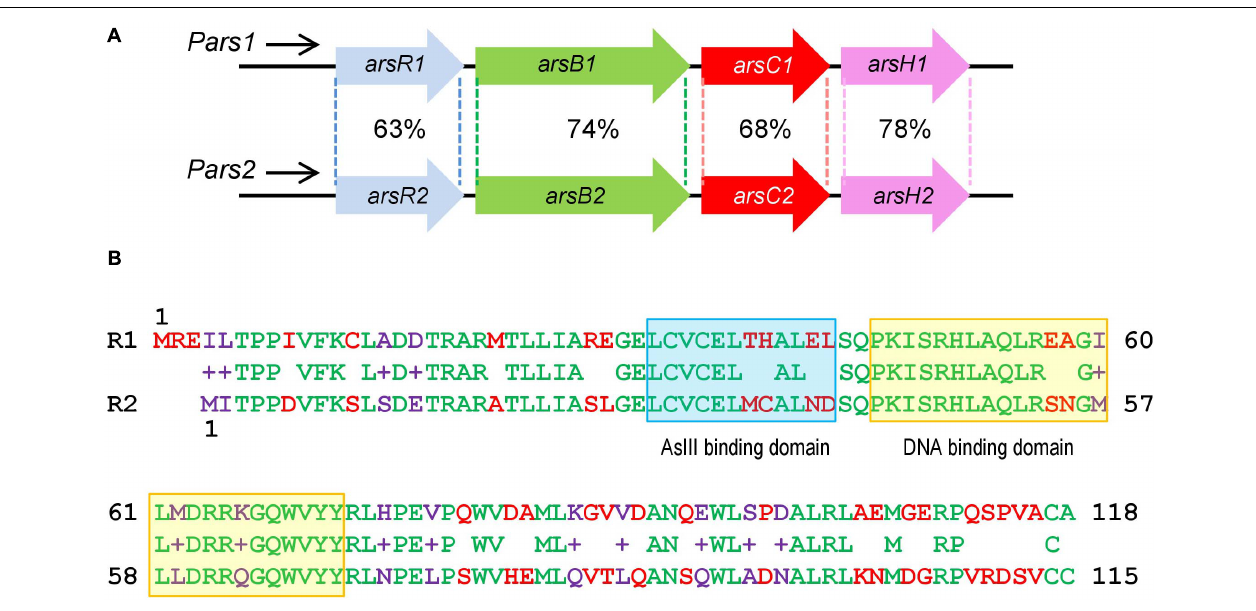
FIGURE 1 | Similarities between Pseudomonas putida KT2440 ars1 and ars2 operons based on sequence identity and length of the alignments. (A) P. putida KT2440 ars operons description: Identity of amino acid sequence between the two ars operons. (B) Comparison of ArsR1 and ArsR2 amino acid sequence. The top amino acid sequence belongs to ArsR1 protein with 118 residues. The bottom belongs to ArsR2 protein with 115 residues. The middle belongs to the sequence alignment. The amino acids are highlighted in green (conserved), red (non-conserved), and purple (non-conserved but it shows functional equivalence). The As (III) binding domain is marked in a blue box and the DNA binding domain is marked in a yellow